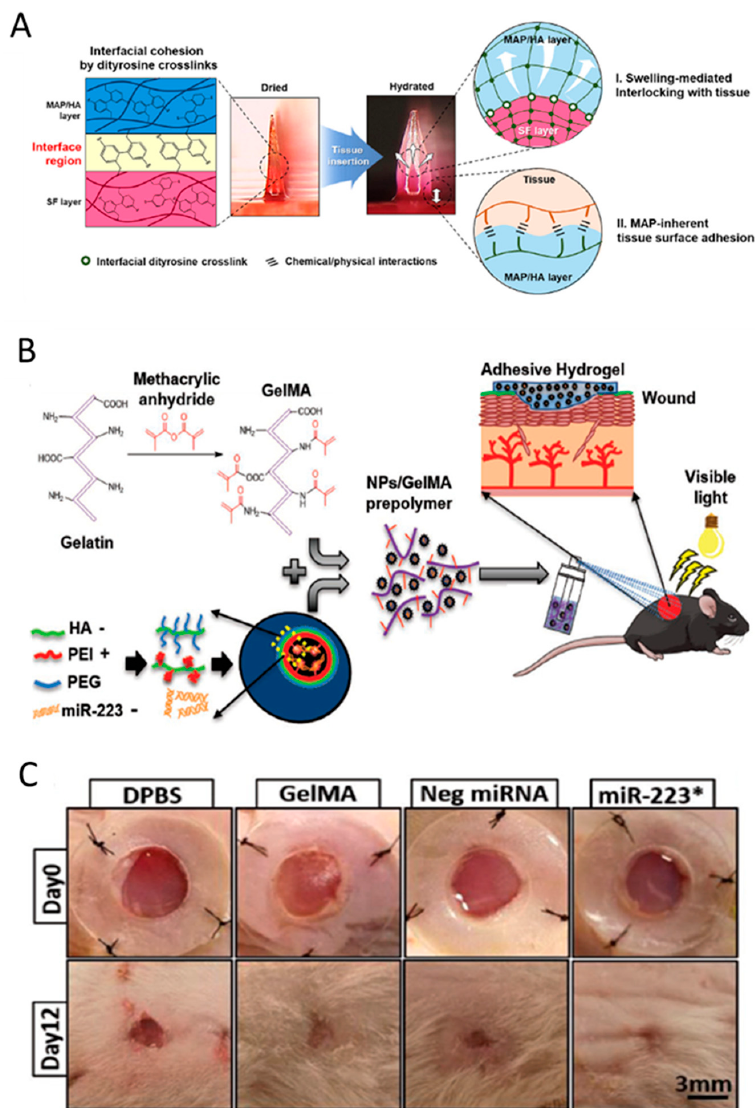
Figure 6. ( A ) Illustration of the mechanisms of a hydrogel-forming adhesive microneedle patch consisting of a mussel adhesive protein-based swellable and sticky shell and a silk fibroin-based non-swellable core. It shows the structure and the reaction of the fabricated patches at the interface with the tissue. Adapted with permission from Jeon et al. [143]. ( B ) Synthesis illustration of the process for the formation of hyaluronic acid nanoparticle / miR-223*-laden GelMA hydrogels and the use of these adhesive hydrogels for wound healing. Adapted with permission from Gao et al. [144]. ( C ) Images of the wounds treated with Dulbecco's phosphate-buffered saline (DPBS), GelMA, Neg miRNA incorporated GelMA, and miR-223* incorporated GelMAat days 0 and 12 of treatment. * Images for animals at day 12 were acquired after removal of the silicon splint to highlight the extent of wound healing. Adapted with permission from Saleh et al.